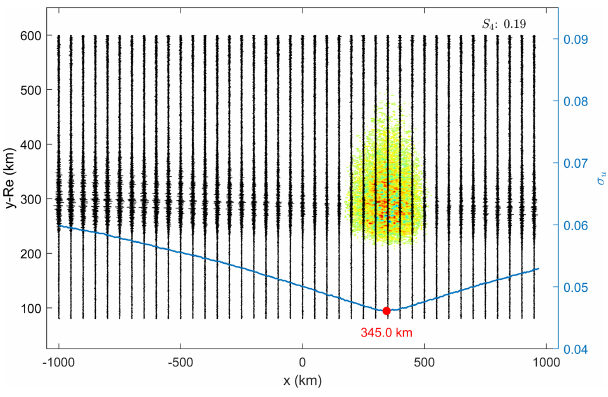
Figure 7. Scenario with single F-layer bubble in the outbound re- gion. The irregularity region was centred around x ref = 346 . 7km, assuming σ (cid:49)ρ/ρ = 17%. Estimation error ε x = 1 .